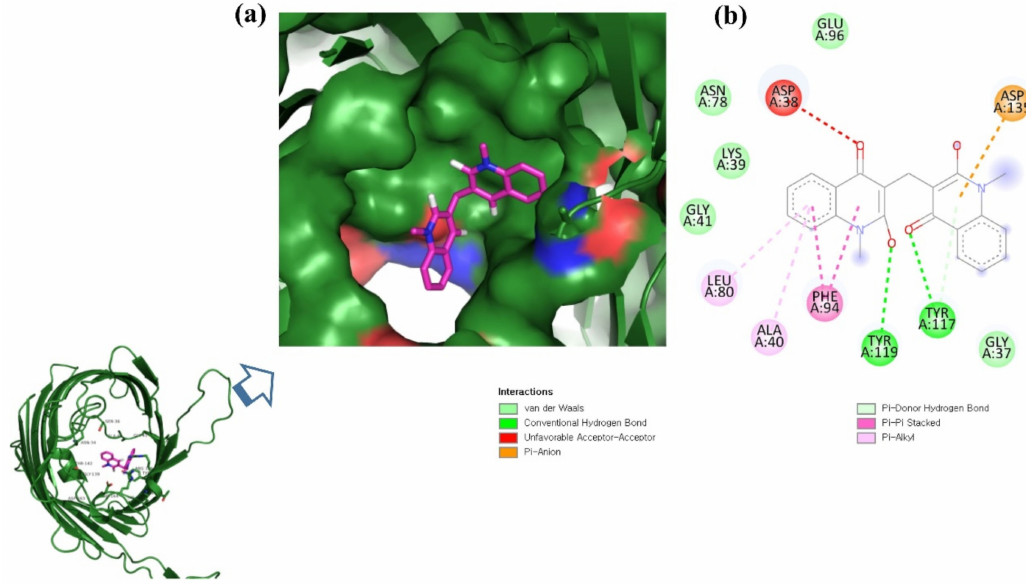
Figure 2. Visualization of ZINC06494587 in the binding pocket of OmpU ( a ); 2D view of residues of OmpU interacting with ZINC06494587 ( b ).